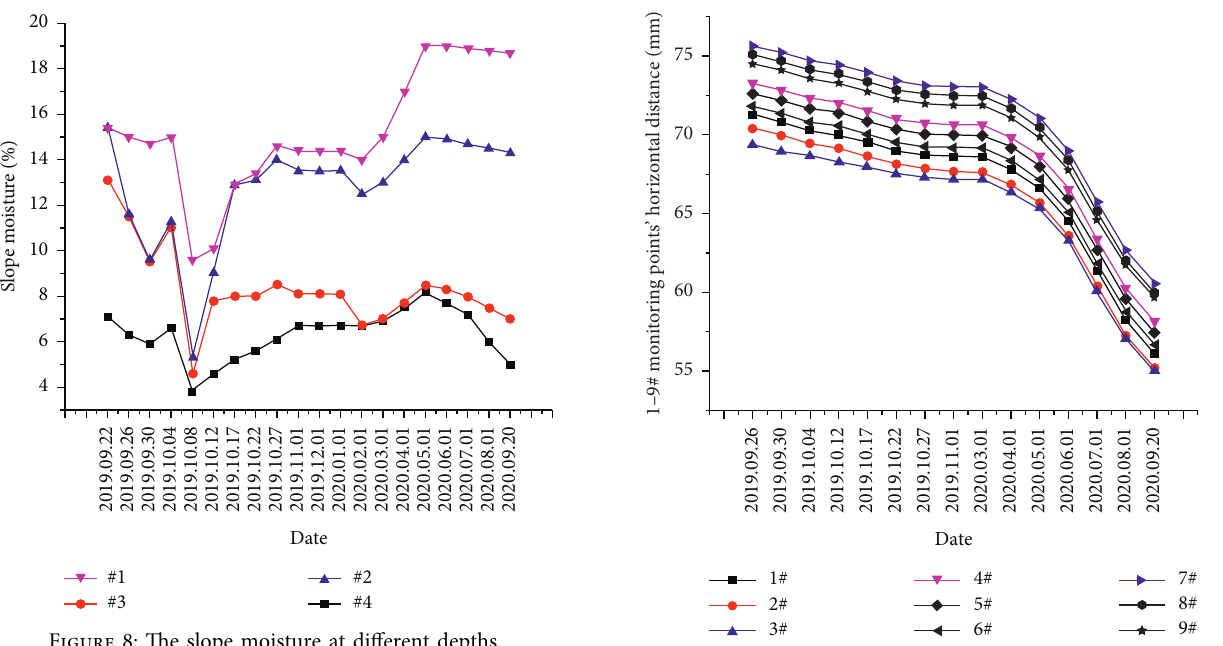
Figure 9: Trend chart of horizontal